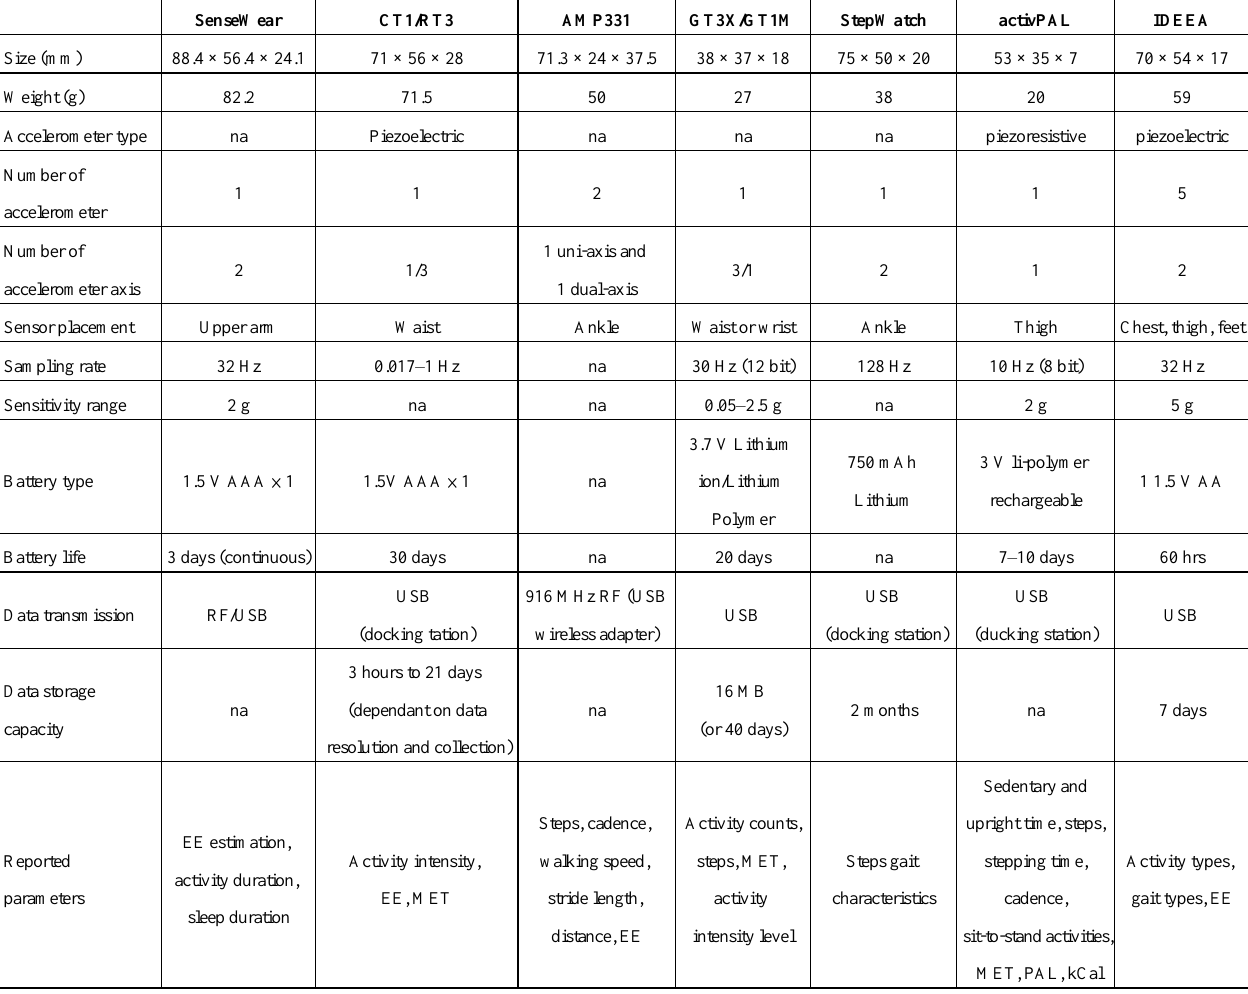
Table 1. Product specification